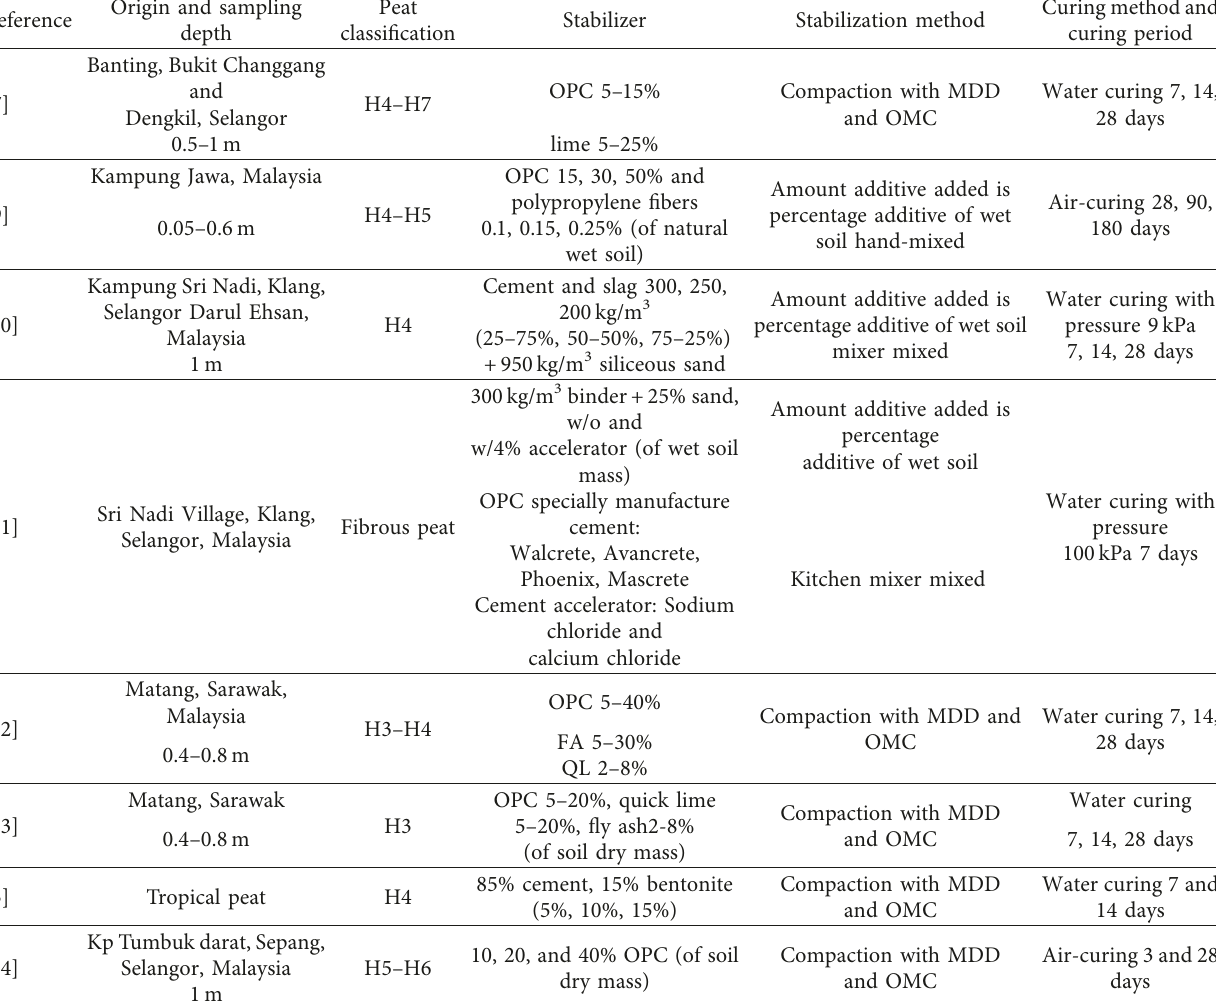
Table 1: Summary of tropical peat chemical stabilization study by some